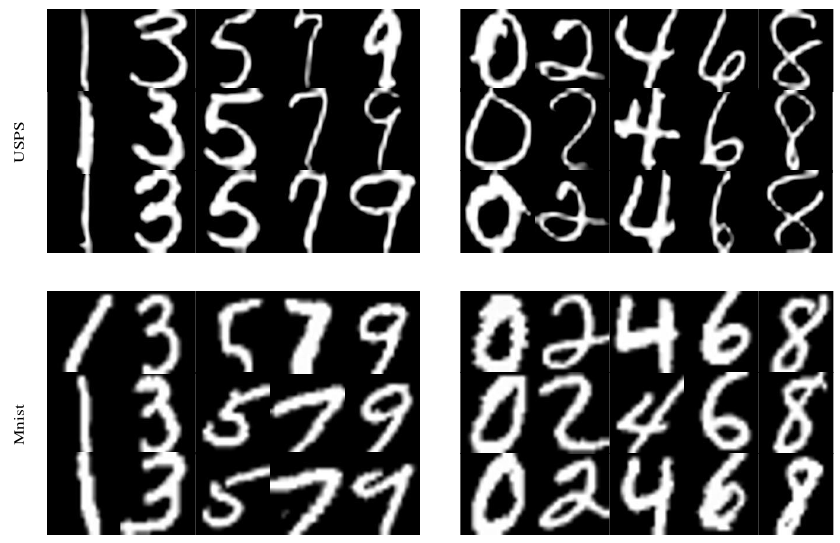
Figure 1. The digit samples in USPS and Mnist; the left is odd digits and right is even FIGURE 1. The digit samples in USPS and Mnist, the left is odd digits and right is even digits. TABLE 2. Information on the Mnist dataset.